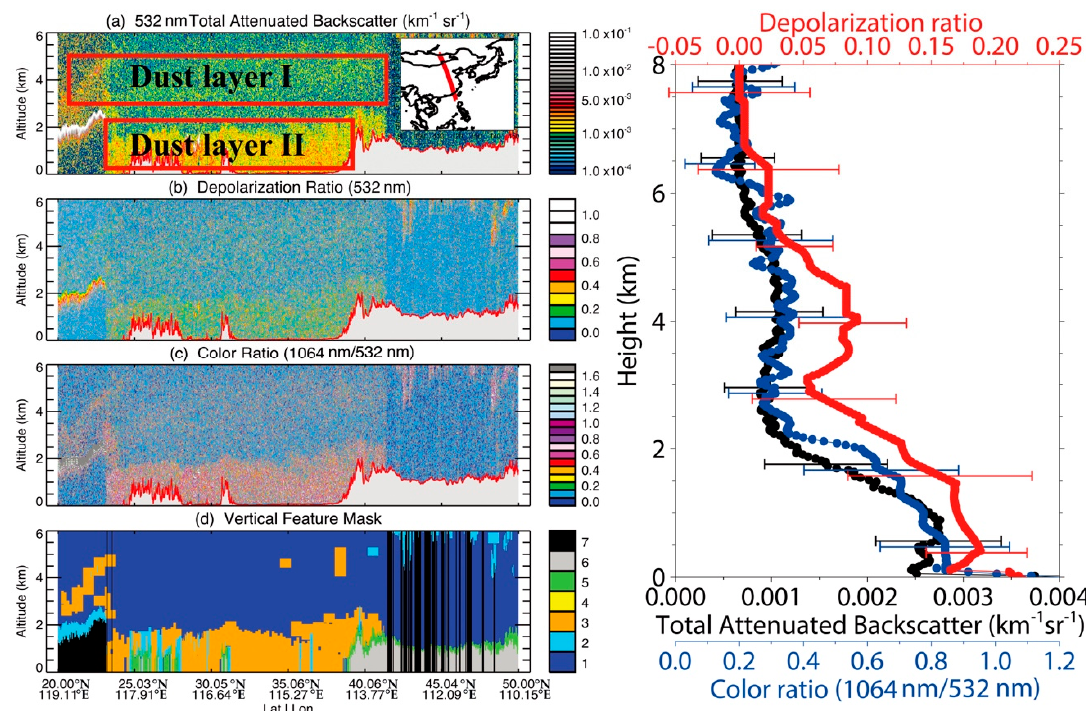
Figure 4. Left panel: vertical structure of the dust aerosols and clouds observed by the CALIPSO lidar over eastern China beginning at 13:09 LST on 14 March 2009. Right panel: mean profiles of total attenuated backscatter at 532 nm (black), depolarization ratio (red) and color ratio (blue) from CALIPSO lidar observation around 13:40 14 March over Eastern China (32°N–38°N, 112°E–116°E). Error bars are standard deviations computed from the vertical bins of each profile. The colored bar of the vertical feature mask (VFM) represents the type of particle layer: 0 = invalid, 1 = clear air, 2 = cloud, 3 = dust, 4 = stratospheric layer, 5 = surface, 6 = subsurface, and 7 = totally attenuated.